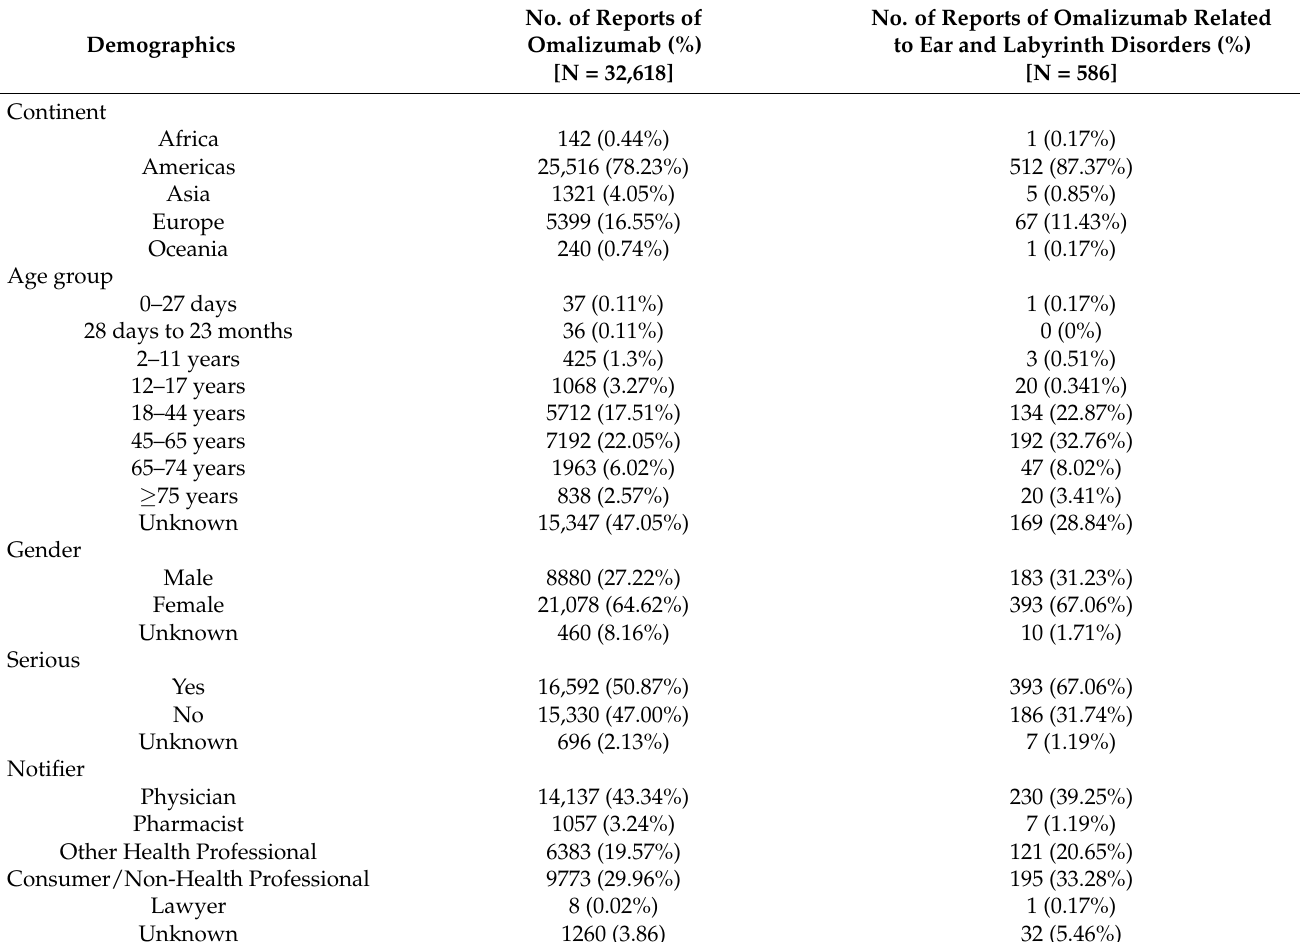
Table 3. Demographic data of omalizumab on